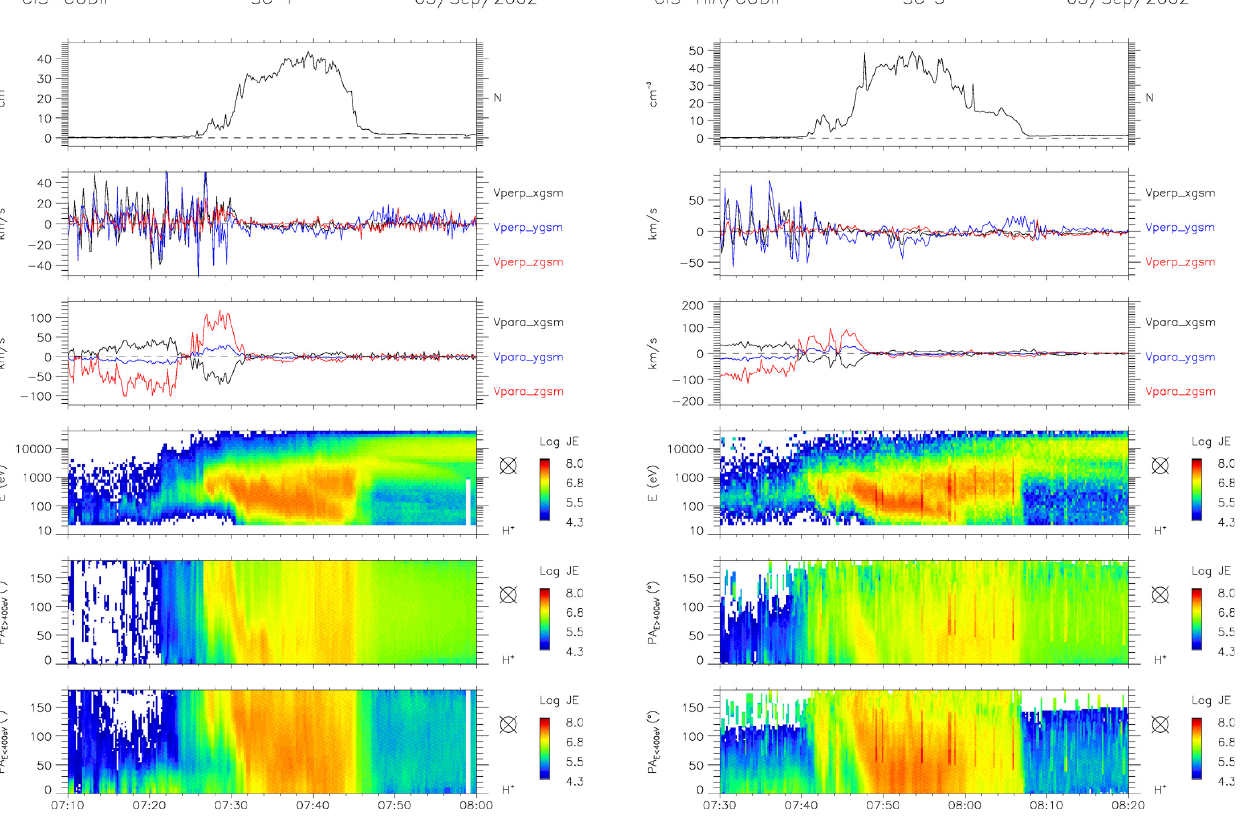
Fig. 4. Same as Fig. 3 for SC4. Fig. 5. Same as Fig. 3 for SC3 except that the moments come from the CIS-HIA